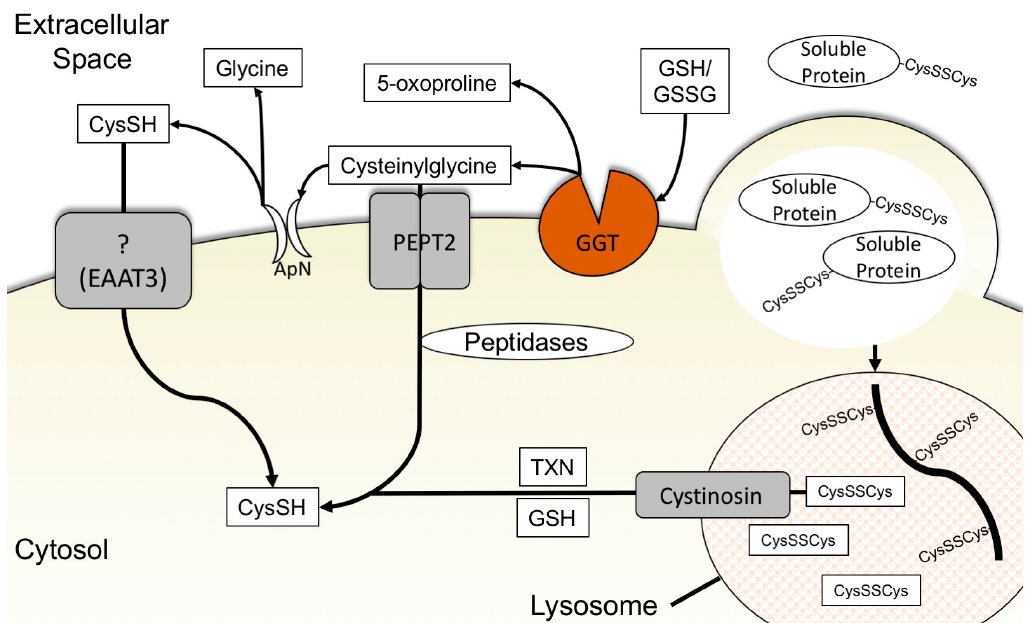
Figure 2. Cells acquire cysteine from extracellular glutathione through the γ -glutamyl cycle, cysteine uptake, and lysosomal protein scavenging by macropinocytosis with cystine export. (Left) Extracellular cysteine is transported into the cell through unidentified cysteine transporters, possibly EAAT3. (Center) The γ -glutamyl bond in extracellular glutathione is cleaved by GGT to create 5-oxoproline and the dipeptide cysteinylglycine. Cysteinylglycine can be taken up by the cell through PEPT2 and cleaved intracellularly by non-specific dipeptidases to cysteine and glycine. Cysteinylglycine may also be cleaved to cysteine and glycine extracellularly by ApN, followed by the cellular uptake of cysteine by cysteine transporters or cystine via xCT (not shown). (Right) Soluble proteins in the extracellular fluid are engulfed by the cell through macropinocytosis. The macropinosome containing proteins travels to and fuses with the lysosome. The disulfide bridges of the proteins are broken, and the protein is linearized by interaction with cysteine imported into the lysosome. The protein is hydrolyzed into its constituent amino acids, including cystine. Lysosomal cystine is subsequently exported to the cytosol by the lysosomal cystine transporter, cystinosin, and reduced by thioredoxin or glutathione to cysteine. ApN: Aminopeptidase N, CysSH: cysteine, CysSSCys: cystine, EAAT3: excitatory amino acid transporter 3, GGT: γ -glutamyltransferase, GSH: glutathione, GSSG: oxidized glutathione, PEPT2: peptide transporter 2, TXN: